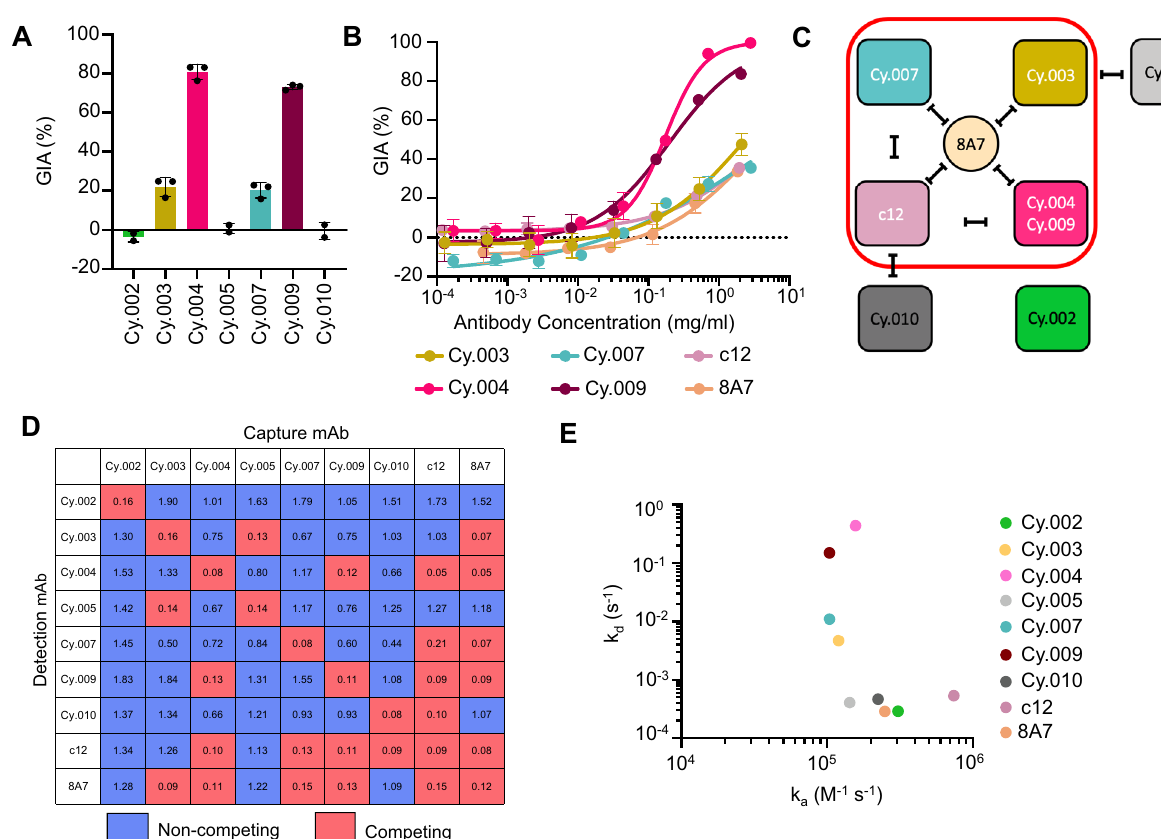
Fig. 1 Characterization of growth inhibitory activity and binding properties of a panel of anti-CyRPA mAbs. A In vitro growth inhibitory activity (GIA) of monoclonal antibodies against the 3D7 clone of P. falciparum at 0.5 mg/ml, individual points indicate the value of each independent replicate, the bar indicates the mean, and errors bars indicate standard deviation across independent replicates ( n = 2, Cy.002, Cy.005 and Cy.010, n = 3 Cy.003, Cy.004, Cy.007, Cy.009). B GIA dilution curve starting at 2 mg/ml of each inhibitory antibody, including chimeric human c12 and 8A7. Points show mean of triplicates and error bars indicate standard deviation. Curve fi t used a four-parameter dose-response curve with the upper bound constrained to 100% GIA. All GIA curves were repeated at least twice with a single representative dilution curve shown here. C Competing interactions between mAbs based on the data in panel ( D ). Red box contains inhibitory mAbs and black lines indicate mAbs that compete with one another. D Competition matrix of all nine anti- CyRPA mAbs. The value contained in each box is the mean OD 405 of a given mAb pair across triplicate; a value <0.25 was taken to be negative binding of the detection mAb. Competing combinations are highlighted in pink. Non-competing pairs are shown in blue. E Kinetic parameters for the binding of each antibody to CyRPA, as determined by surface plasmon resonance mAbs Cy.003 and Cy.007 had higher af fi nities of 3 : 8 ´ 10 (cid:1) 8 and 1 : 1 ´ 10 (cid:1) 7 M, respectively (Fig. 1E and Supplementary Table 1). The measured af fi nities for c12 and 8A7 (1 : 2 ´ 10 (cid:1) 9 M) align with previously reported values 18,25 , indicating that the change to a human IgG1 constant domain did not affect binding af fi nity.